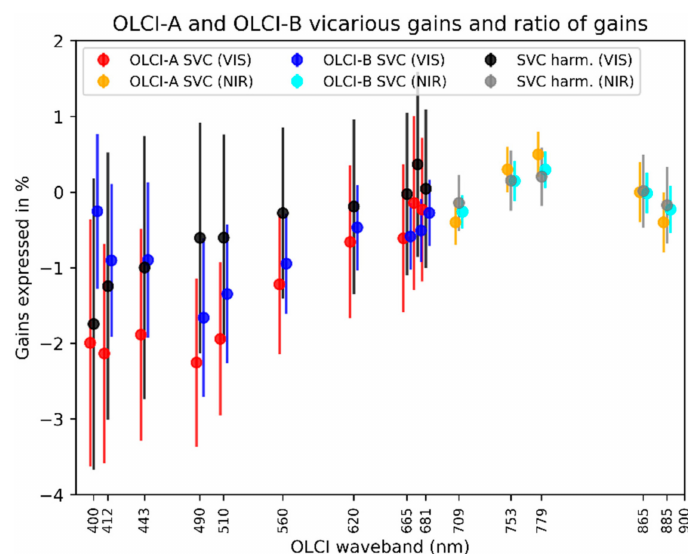
Figure 3. Comparison between the current OLCI-A (red / orange) and preliminary OLCI-B (blue / cyan) SVC gains, and a tentative set of SVC harmonisation gains (black / grey) along with associated dispersions. Gains at 1020 nm falls out of the scale and are not